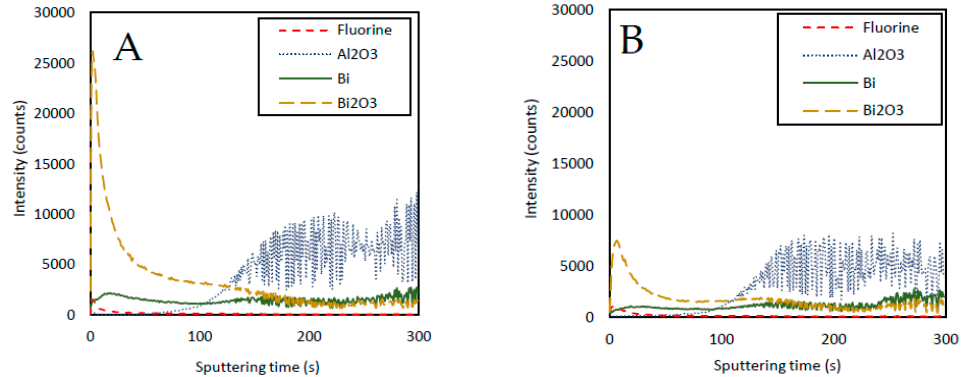
Figure 7. TOF-SIMS results for commercial Bi SP SPE: ( A ) New electrode. ( B ) Electrode after 25 voltammetric runs (SWASV as indicated in section 2.5).